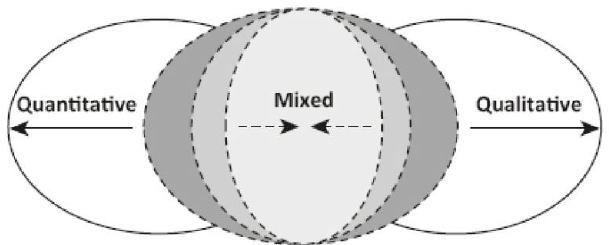
Figure 4 . Illustration of mixed method research (Clark & Ivankova